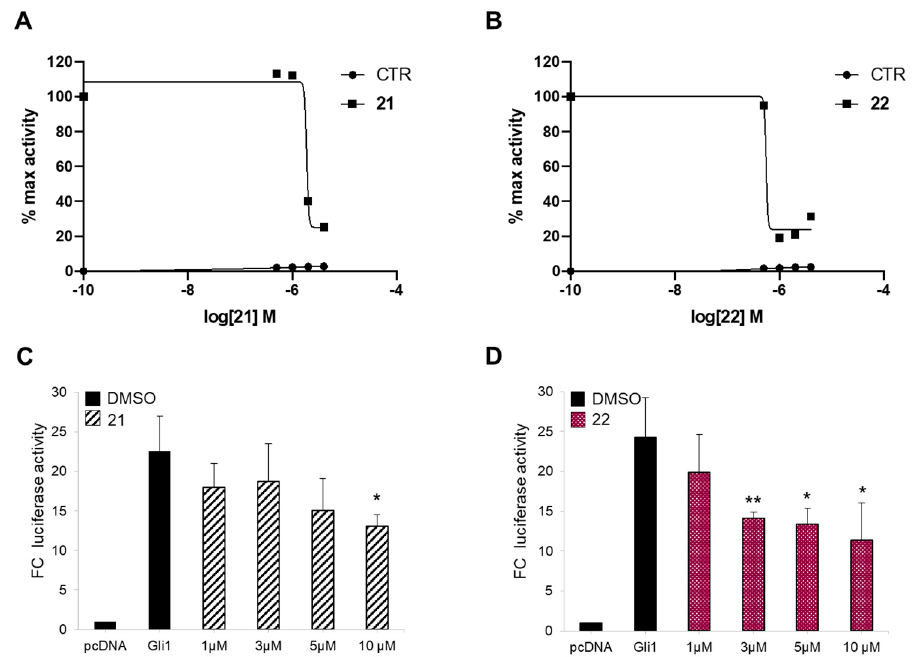
Figure 2. Hh inhibition by compounds 21 and 22 . The dose-response curve in SAG-treated NIH3T3 Shh-Light II cells ( A,B ) or mouse embryonic fibroblasts (MEFs) transfected with 12XGliBS-Luc and pRL-TK Renilla (normalization control) plus control (empty) or Gli1 vector ( C,D ). Cells were treated with increasing concentrations of compounds 21 ( A,C ) and 22 ( B,D ). Treatment time was 48 h and 24 h for NIH3T3 Shh-Light II cells and transfected MEFs, respectively. Data were normalized against Renilla luciferase. Data show the mean ± SD of three independent experiments. (*) p < 0.05 vs. SAG or Dimethyl sulfoxide (DMSO); (**) p < 0.01 vs. SAG or DMSO.